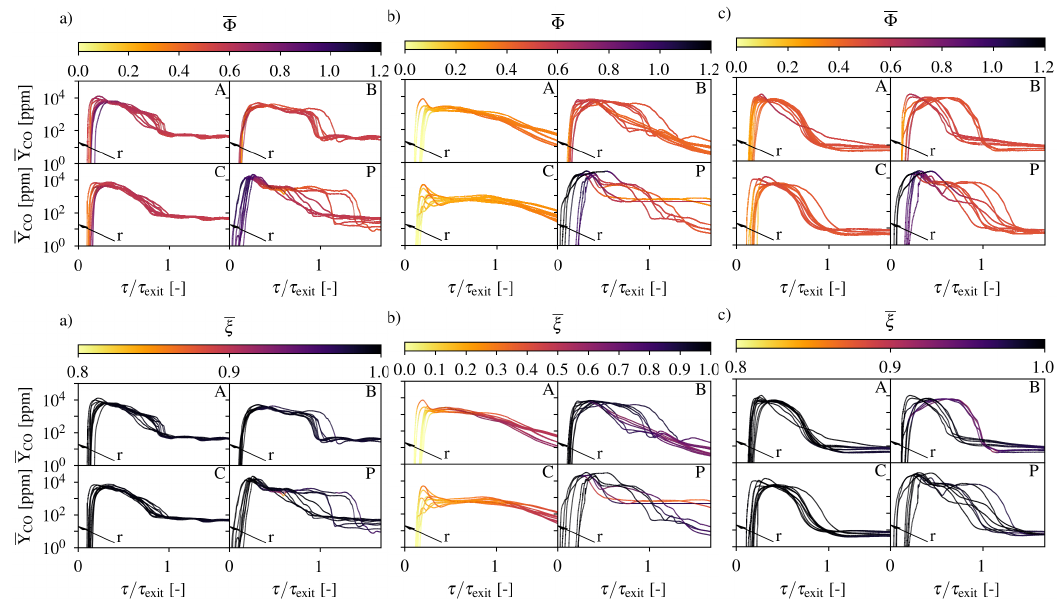
Figure 10. Lagrangian particle history of carbon monoxide in dependency of the equivalence ratio Φ (top row) and the primary air ratio ξ (bottom row) from the different stages for case ( a ) 1, ( b ) 2 and ( c ) 3. Time is normalized by the combustor exit time τ exit . The temporal shift is related to the injection radius r